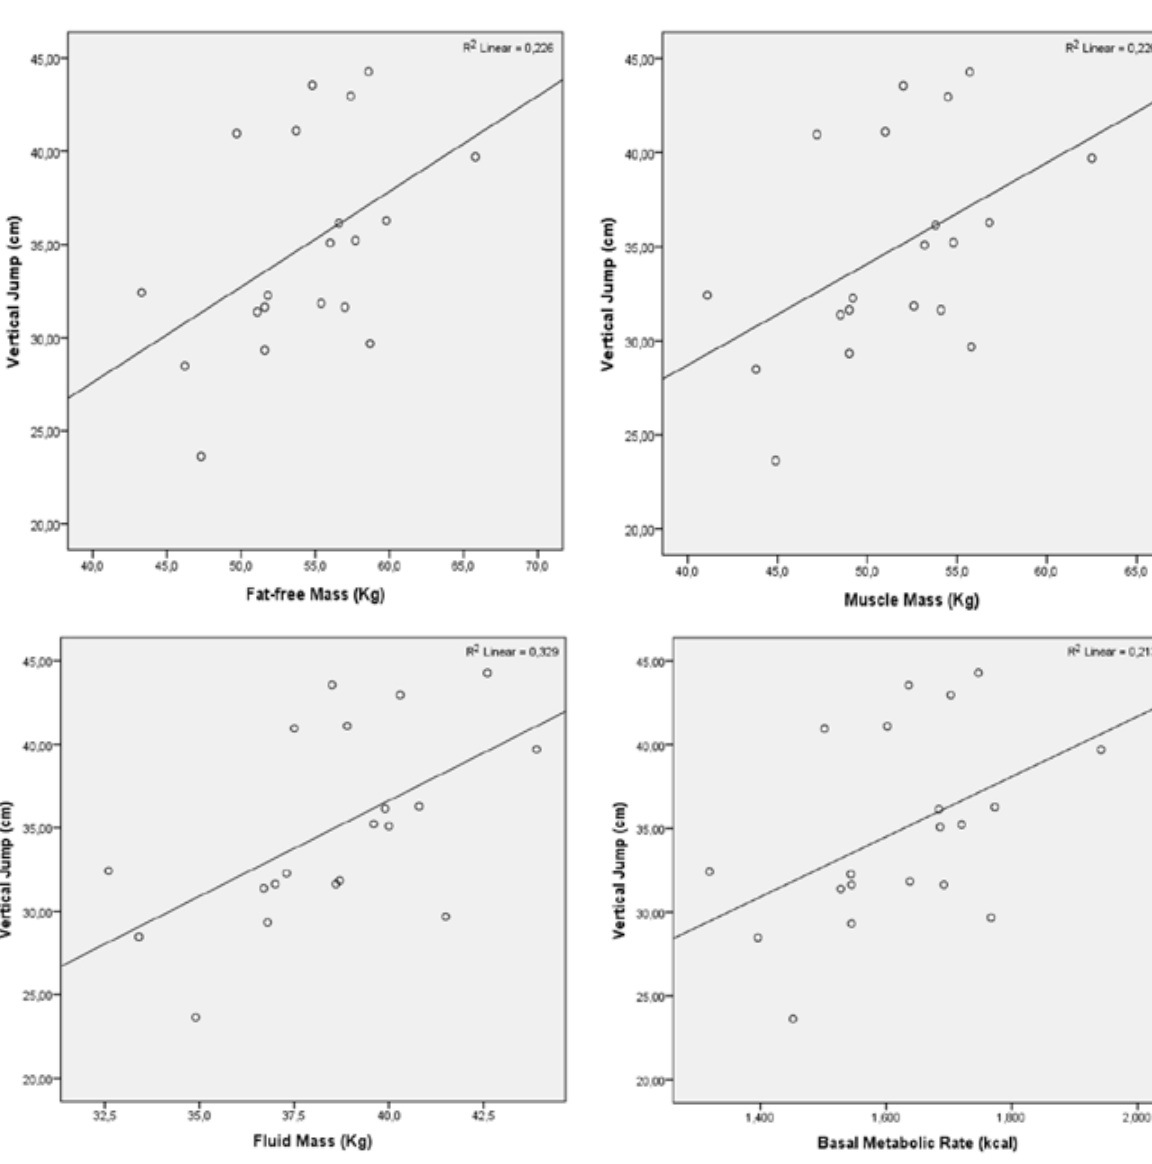
Figure 1. The relationships between vertical jump and lean (fat-free) mass, muscle mass, fluid (liquid) mass, and basal metabolic